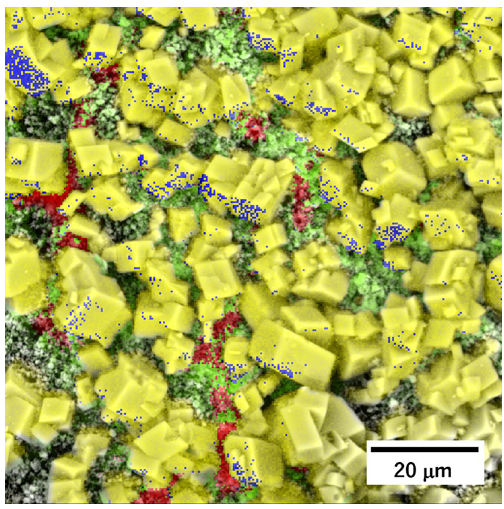
Fig. 5 Energy dispersive X-ray spectroscopy elemental mapping of the AuNP/TiO /CaCO (4.0 g) catalyst superimposed on the corre- 2 3 sponding scanning electron microscopy image. The following ele- ments were found: blue: O; red: C; yellow: Ca; green: Ti